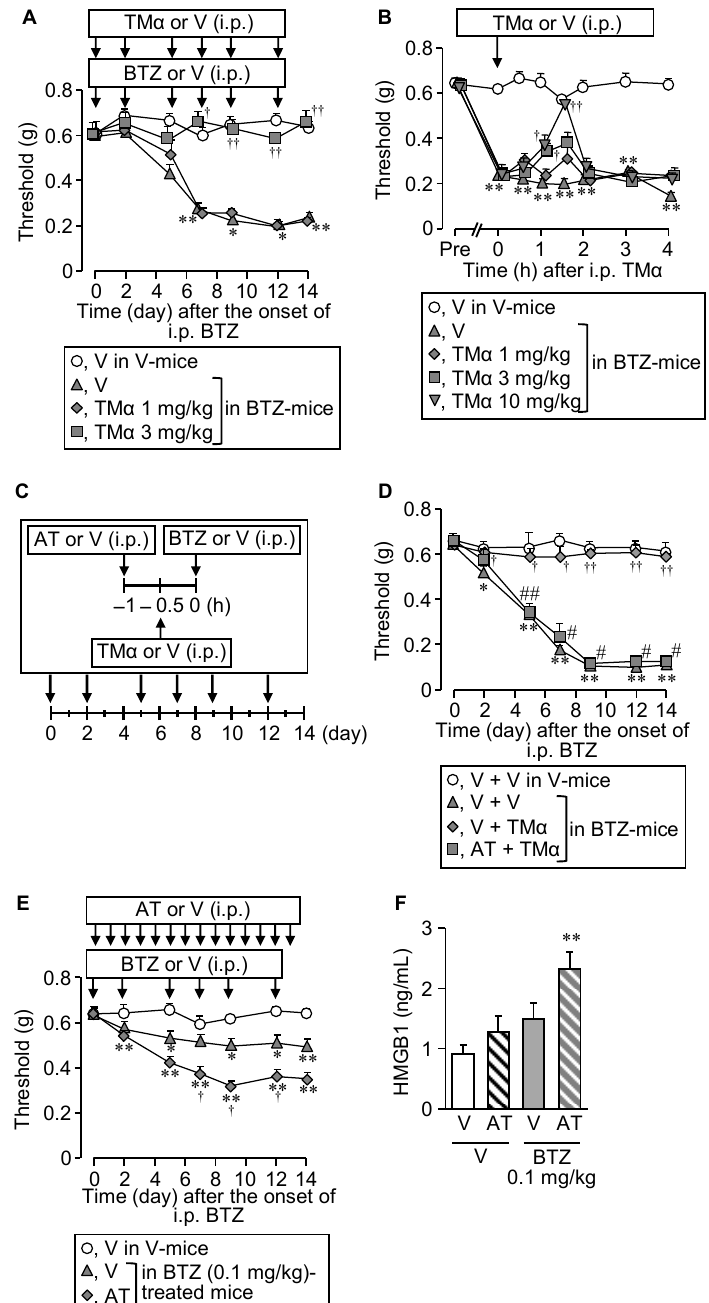
Figure 2. Prevention and reversal of the CIPN caused by bortezomib by thrombomodulin alfa, and the role of endogenous thrombin. ( A , B ) Preventive ( A ) or therapeutic ( B ) effects of thrombomodulin alfa on the CIPN caused by bortezomib in mice. Bortezomib at 0.4 mg/kg or vehicle was